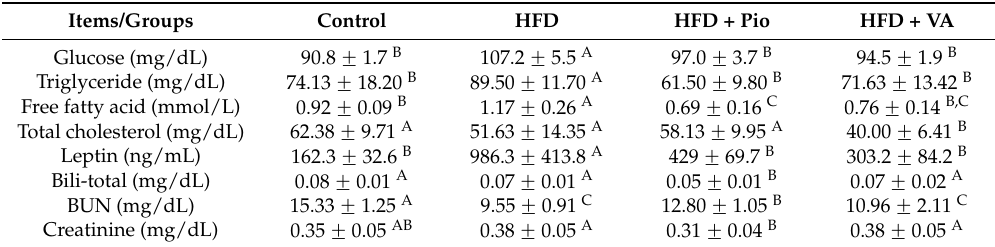
Table 3. The fasting serum parameters in rats fed high-fat diet for 16 weeks and orally administered with vanillic acid during the last 4